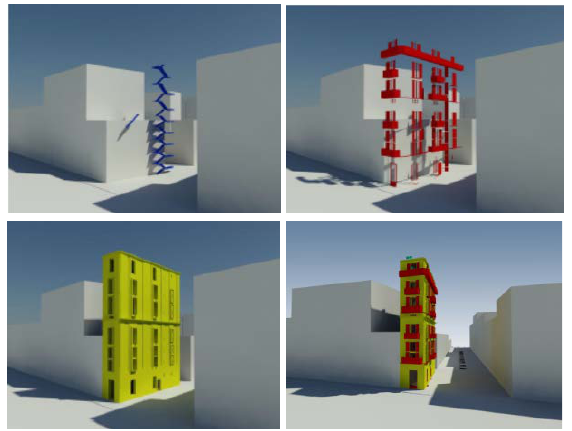
Figure 6. The “Fetta di polenta”